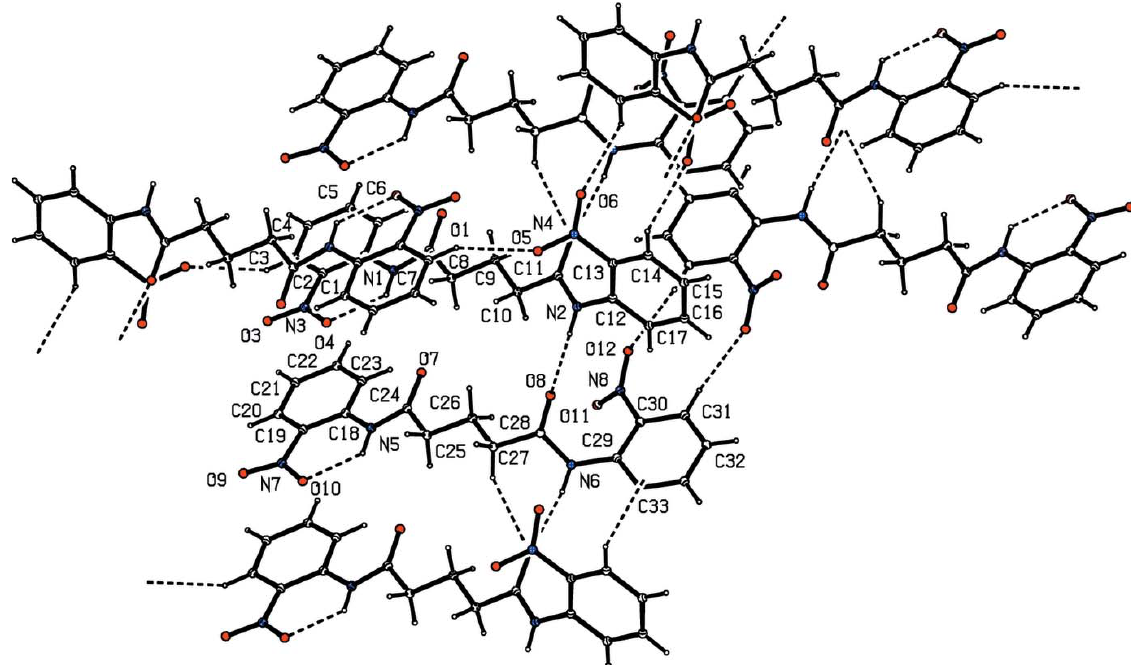
Figure 2 Hydrogen-bonding pattern in (I) with hydrogen bonds shown as dashed lines.